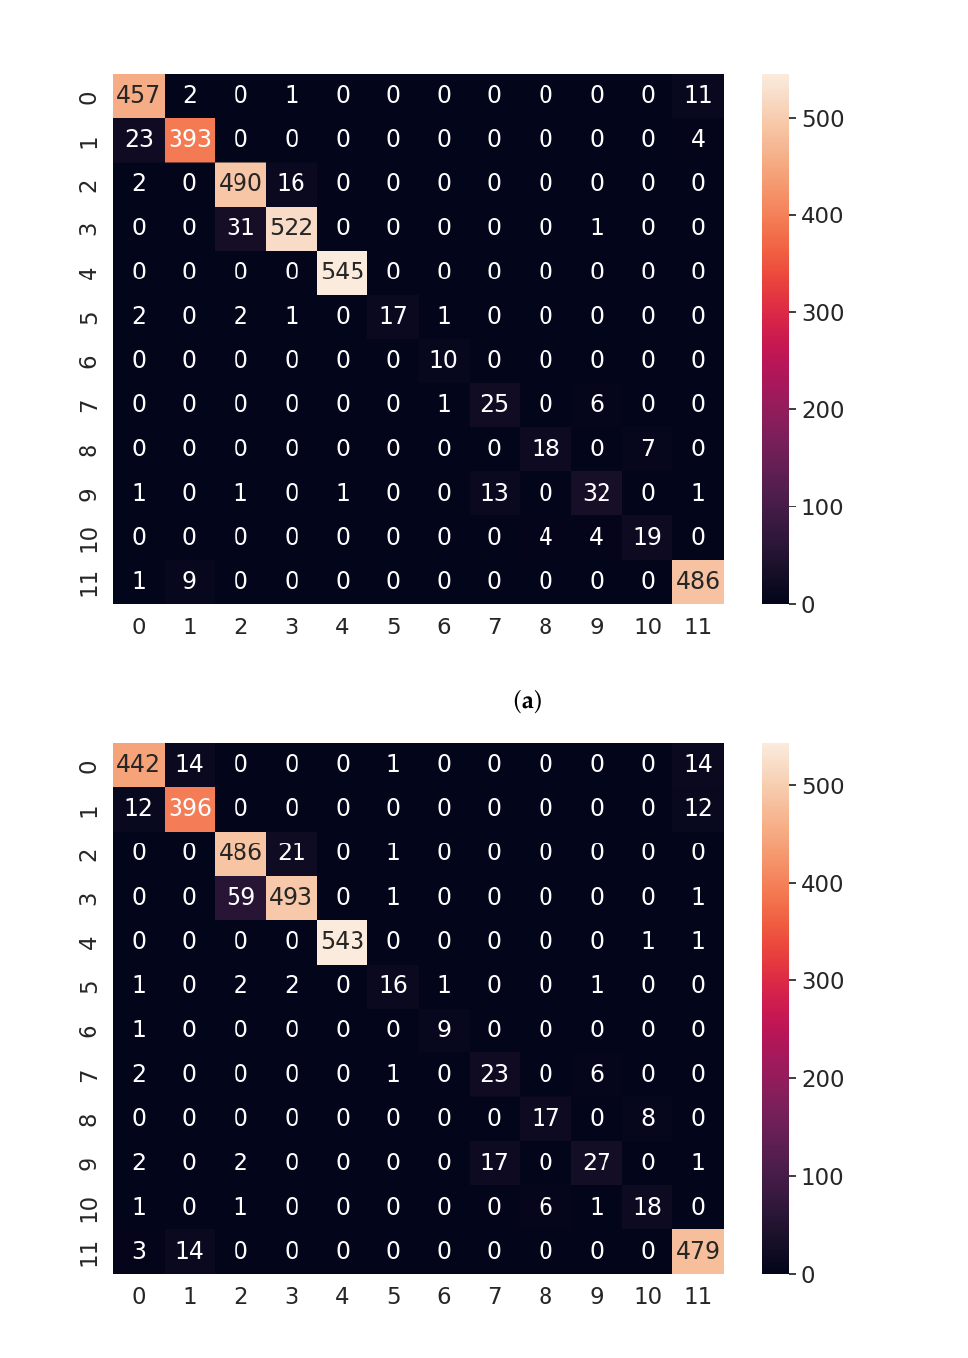
Figure 11. The confusion matrix of a trained architecture on the test set of the HADB dataset in the case of the reference CNN model ( a ) and in the case of our kervolutional neural network model ( b ). As one can see, the two confusion matrices were qualitatively similar, and although there were more misclassifications in the case of the SAW convolver (which was natural since it had a slightly lower accuracy), the distribution of the errors was similar. (The number labels mean the following: 0 = walking, 1 = walking upstairs, 2 = walking downstairs, 3 = sitting, 4 = standing, 5 = laying, 6 = stand to sit, 7 = sit to stand, 8 = sit to lie, 9 = lie to sit, 10 = stand to lie, and 11 = lie to